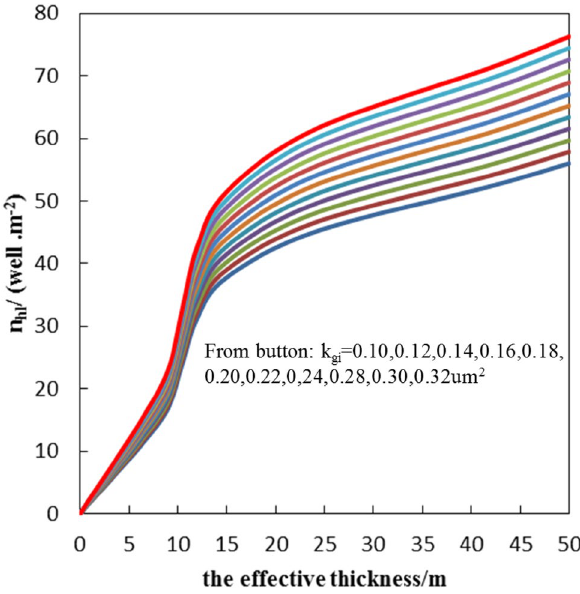
Fig. 8 The curve of reasonable well spacing density in different phys- ical properties